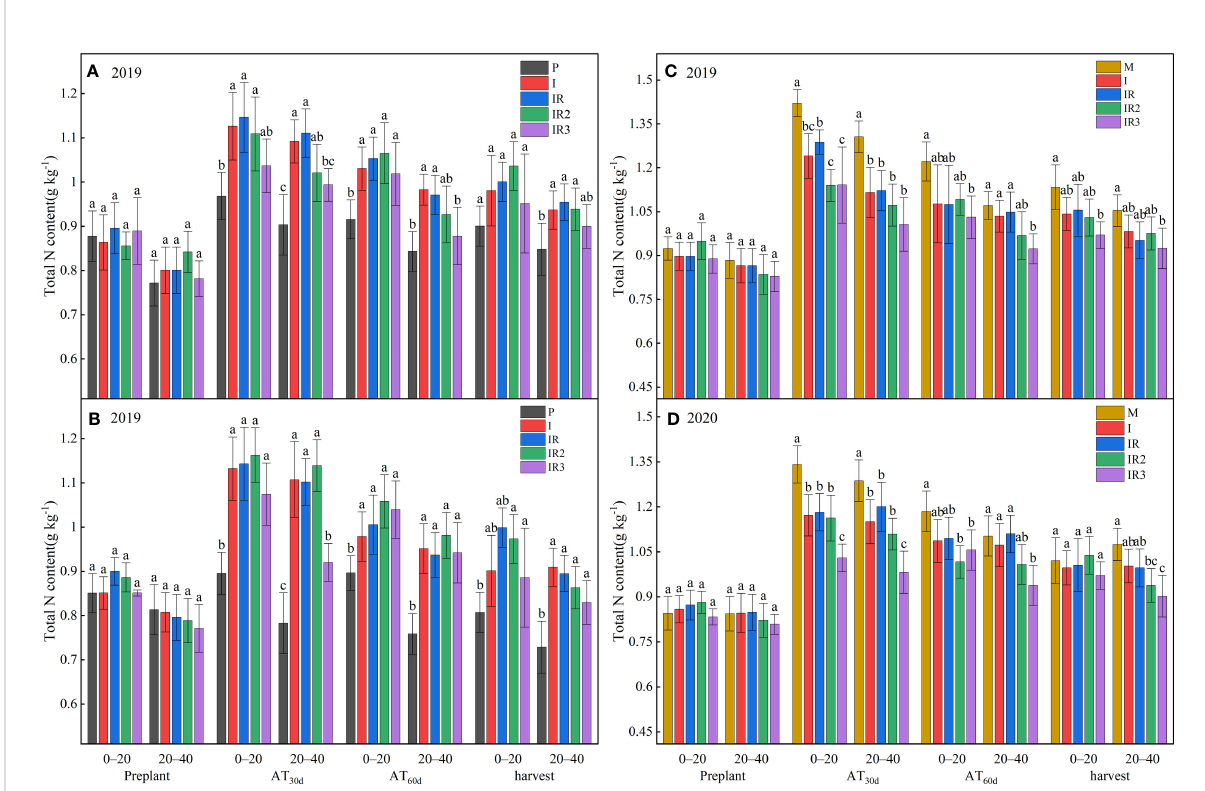
FIGURE 2 Total N content in 0 – 20 and 20 – 40 cm soil in peanut planting strip (A, B) and maize planting strip (C D) . P, sole peanut; M, sole maize; I, maize – peanut intercropping; RI, maize – peanut rotation – intercropping, RI2, 20% N reduction for maize of RI; ICN3, 40% N reductions for maize of RI. Different lowercase letters represent signi fi cant